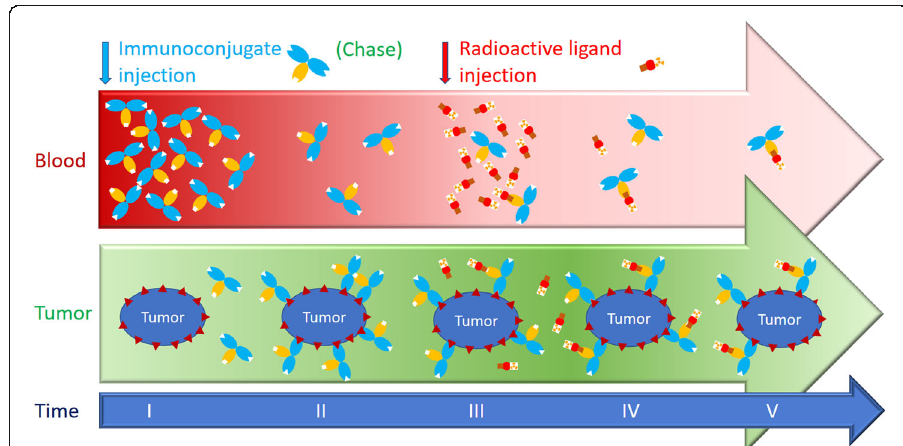
Fig. 1 Pretargeting dosing schedule. The unlabelled immunoconjugate is injected first (I). It is allowed to distribute and bind the tumour for several hours or days (II). Then, the radioactive ligand is injected (III). It distributes rapidly and binds the tumour-associated immunoconjugate (IV). It also binds the circulating immunoconjugate that remains in the circulation. The immunoconjugate and the radiolabelled ligand must be carefully designed and the dosing schedule must be optimized to achieve the best tumour to tissue contrast ratios or the best irradiation dose ratio (V). If the amount of immunoconjugate remaining in the circulation is too high, the radiolabelled ligand is trapped in the circulation, reducing the contrast ratios and increasing the irradiation of normal tissues. If the immunoconjugate dose is insufficient, or if the radiolabelled ligand is injected too late, clearance of the immunoconjugate results in its wash-out from tumours and consequently the uptake of radioactivity in the tumour is reduced. To solve the problem, some pretargeting strategies use a clearing agent to chase the excess circulating immunoconjugate (Forero et al. 2004; Houghton et al. 2017; Knox et al. 2000; Paganelli et al. 2001). In other strategies, bivalent haptens, which bind more tightly to cell-bound than to circulating immunoconjugates, are used to carry the radionuclide (Bodet-Milin et al. 2016; Chatal et al. 2006; Gautherot et al. 2000; Kraeber-Bodéré et al. 1999; Kraeber-Bodéré et al. 2006; Kraeber-Bodéré et al. 2015; Peltier et al. 1993; Salaun et al. 2012; Schoffelen et al. 2010; Schoffelen et al. 2013; Schoffelen et al.